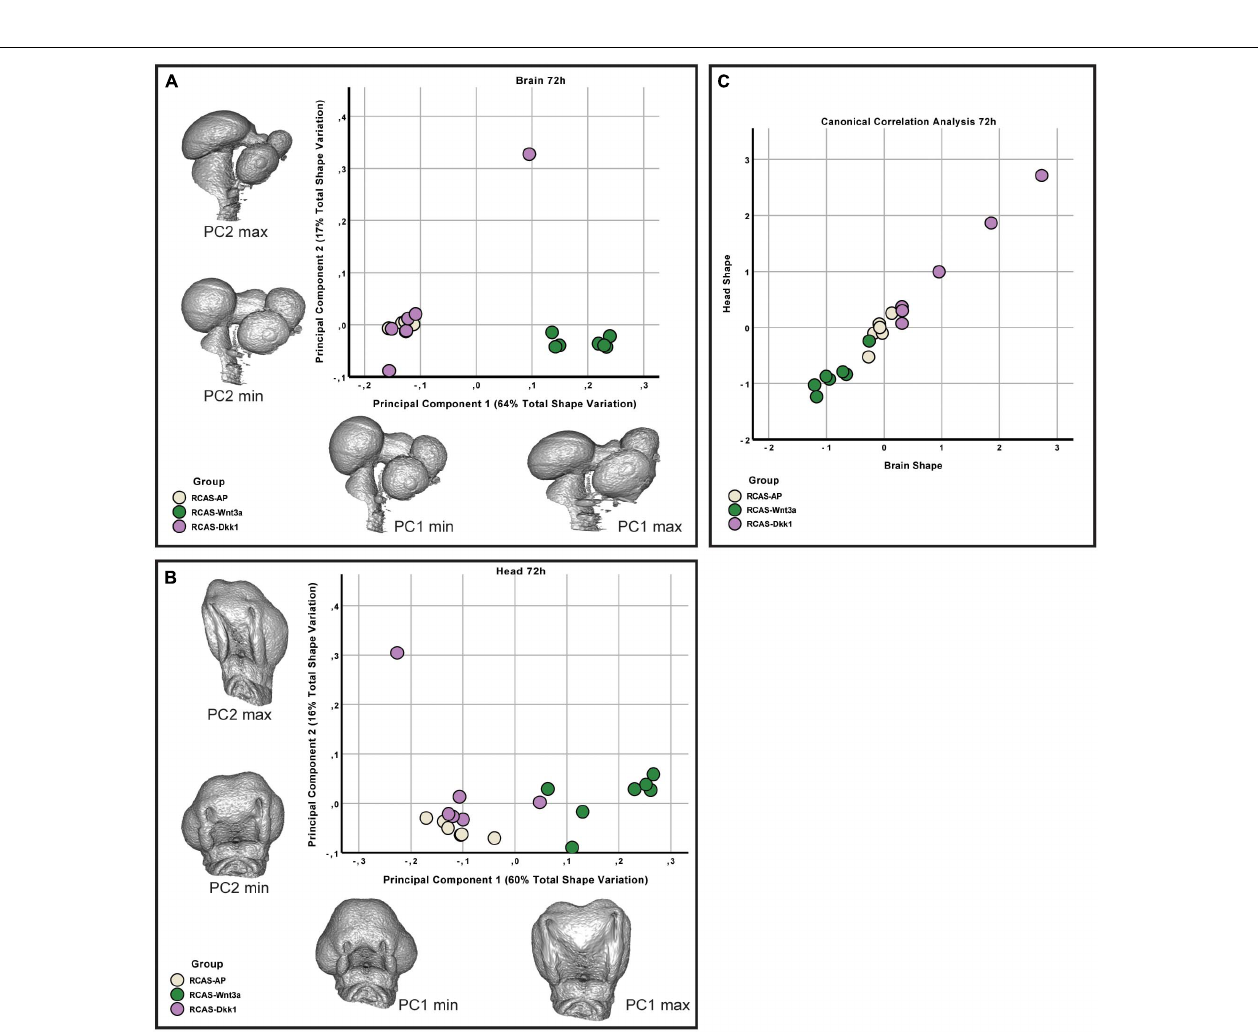
FIGURE 6 | Brain and head shape variation between RCAS-Ap, RCAS- Dkk1 and RCAS- Wnt3a at stage HH22. (A) Biplot of the first two principal components of the brain based on 17 landmarks. Gray meshes represent brain shape at the extreme of the principal component. (B) Biplot of the first two principal components of the head based on 21 landmarks. Gray meshes represent head shape at the extreme of the principal component. (C) Canonical correlation analysis of the first three principal components of the head and of the brain.